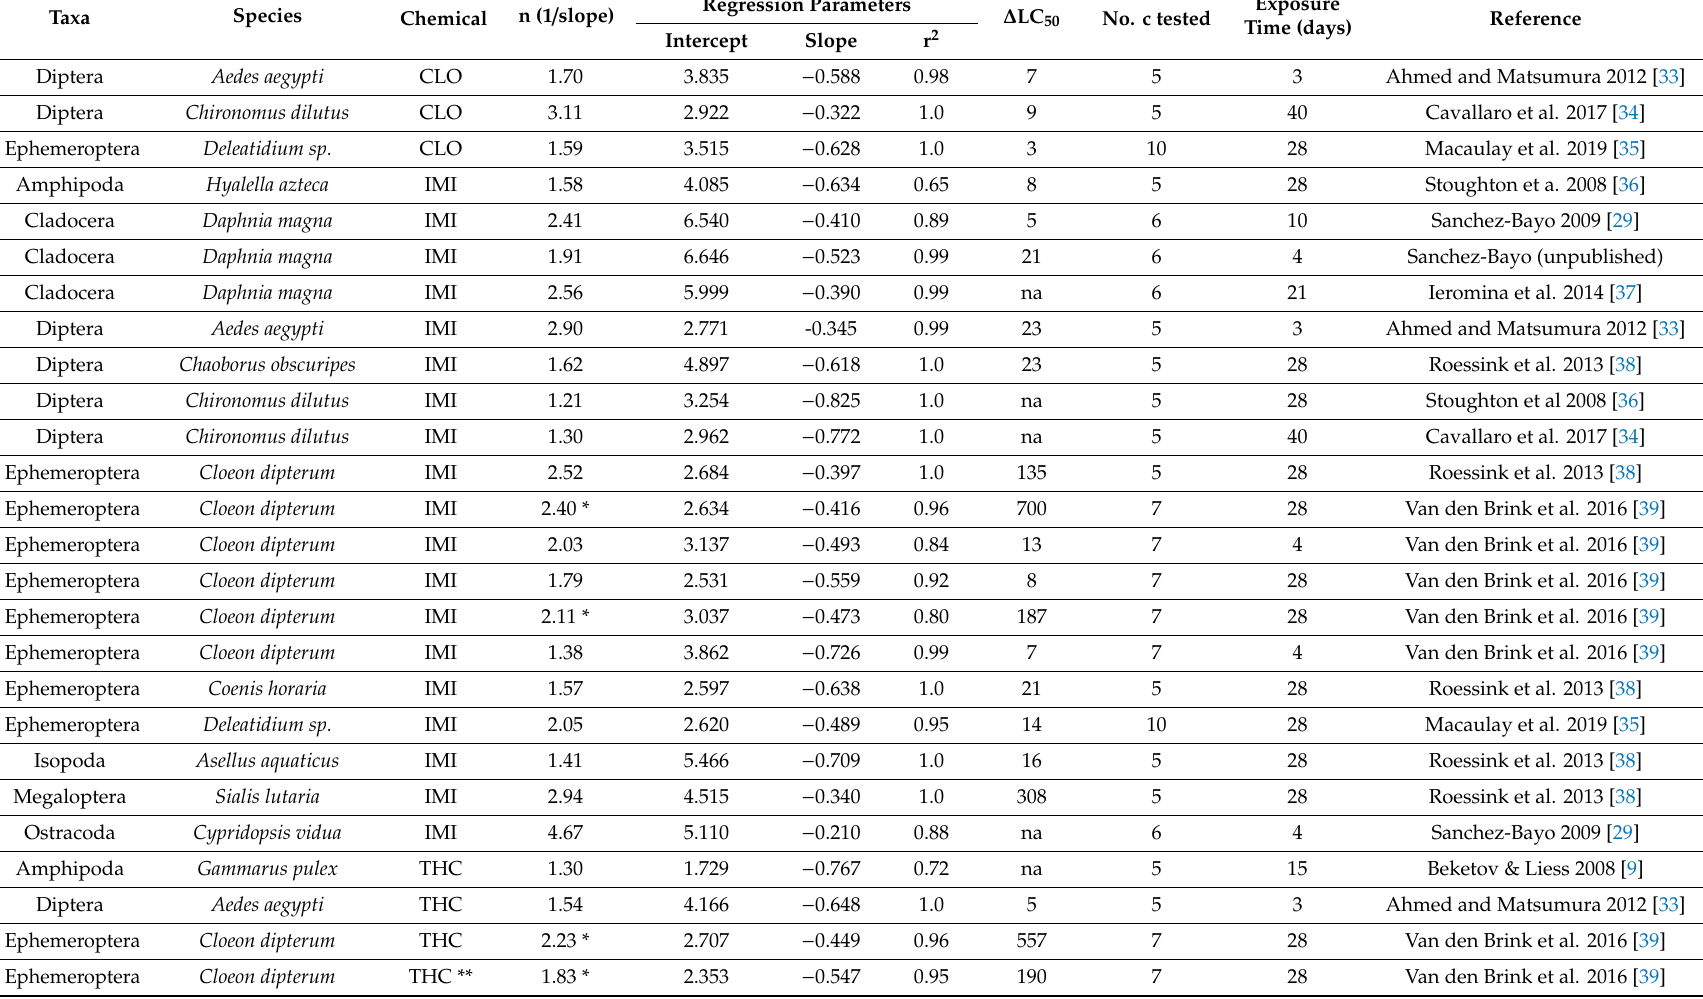
Table 3. Time-cumulative toxicity of neonicotinoids in aquatic